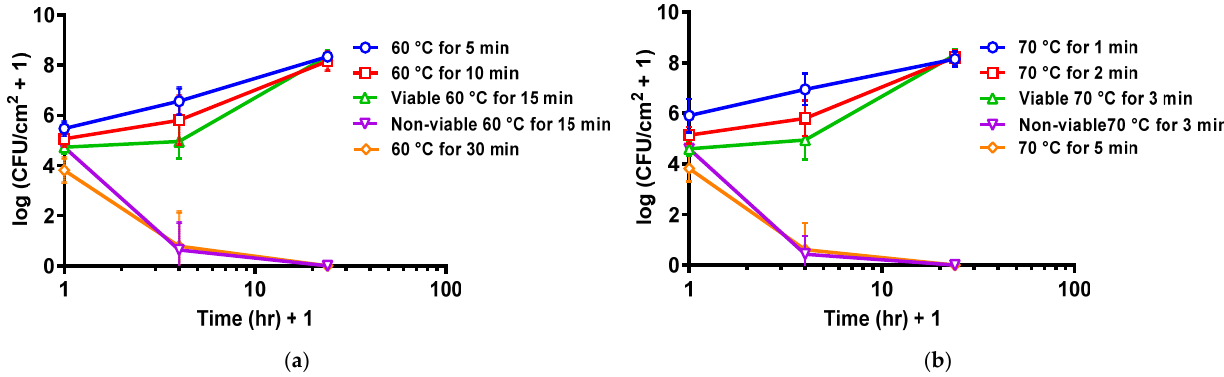
Figure 2. Critical population density for DFR biofilm reincubation. ( a ) Population density for DFR biofilm reincubation after thermal shock at 60 °C. ( b ) Population density for DFR biofilm reincubation after thermal shock at 70 °C. Error bars indicate standard deviation for at least six slides from three different dishes.